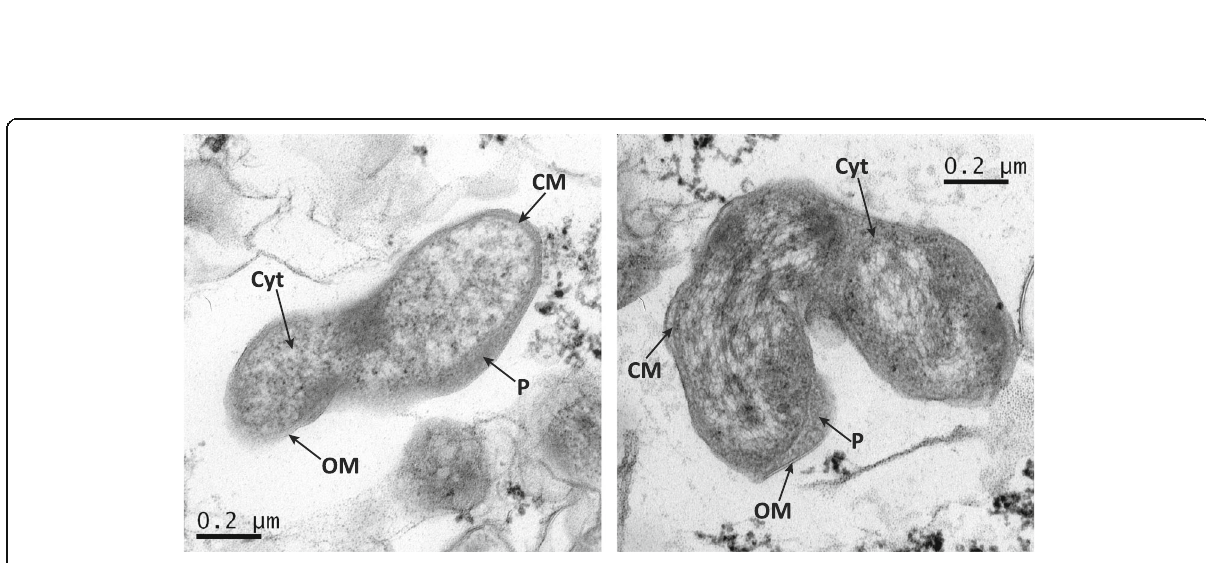
Fig. 2 Electron micrographs of “ N. lenta ” strain BS10. The cells, in accordance to most of the bacteria belonging to the genus Nitrospira , feature a characteristic spiral shape and an enlarged periplasm. The individual cell components are indicated. OM, outer membrane; P, periplasm; CM, cytoplasmic membrane; Cyt,